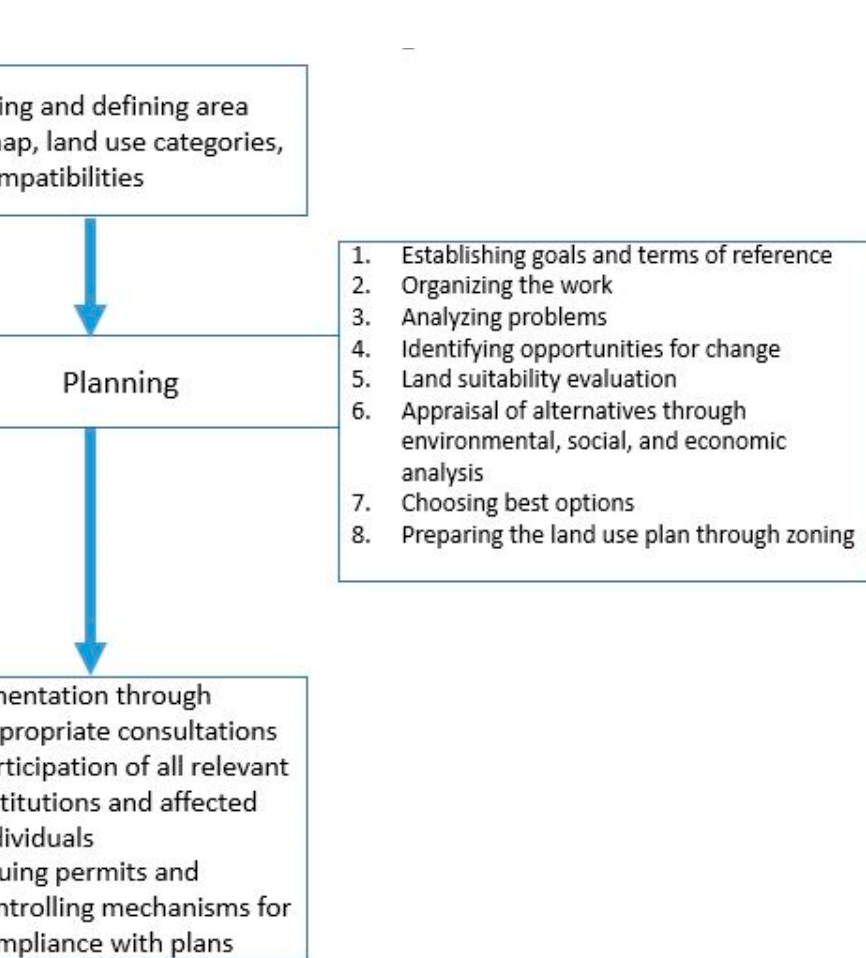
Figure 6. Land use planning and development process. Authors’ construct.